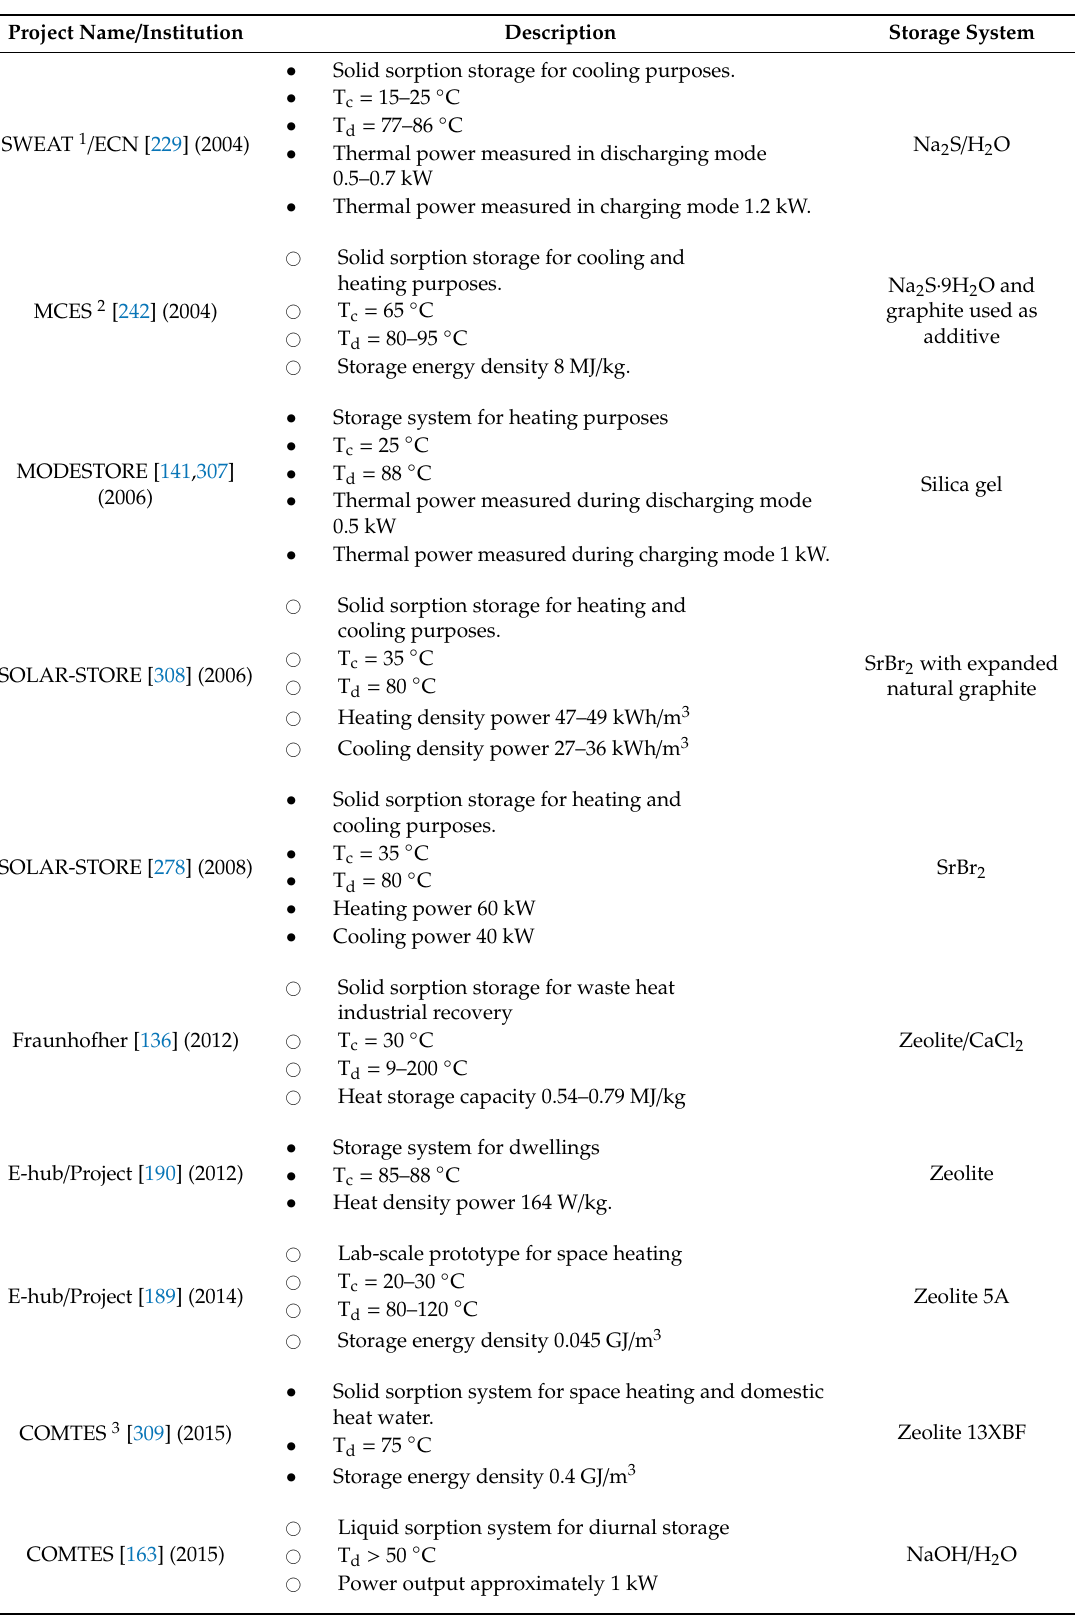
Table 3. Example of prototypes of closed systems for thermochemical